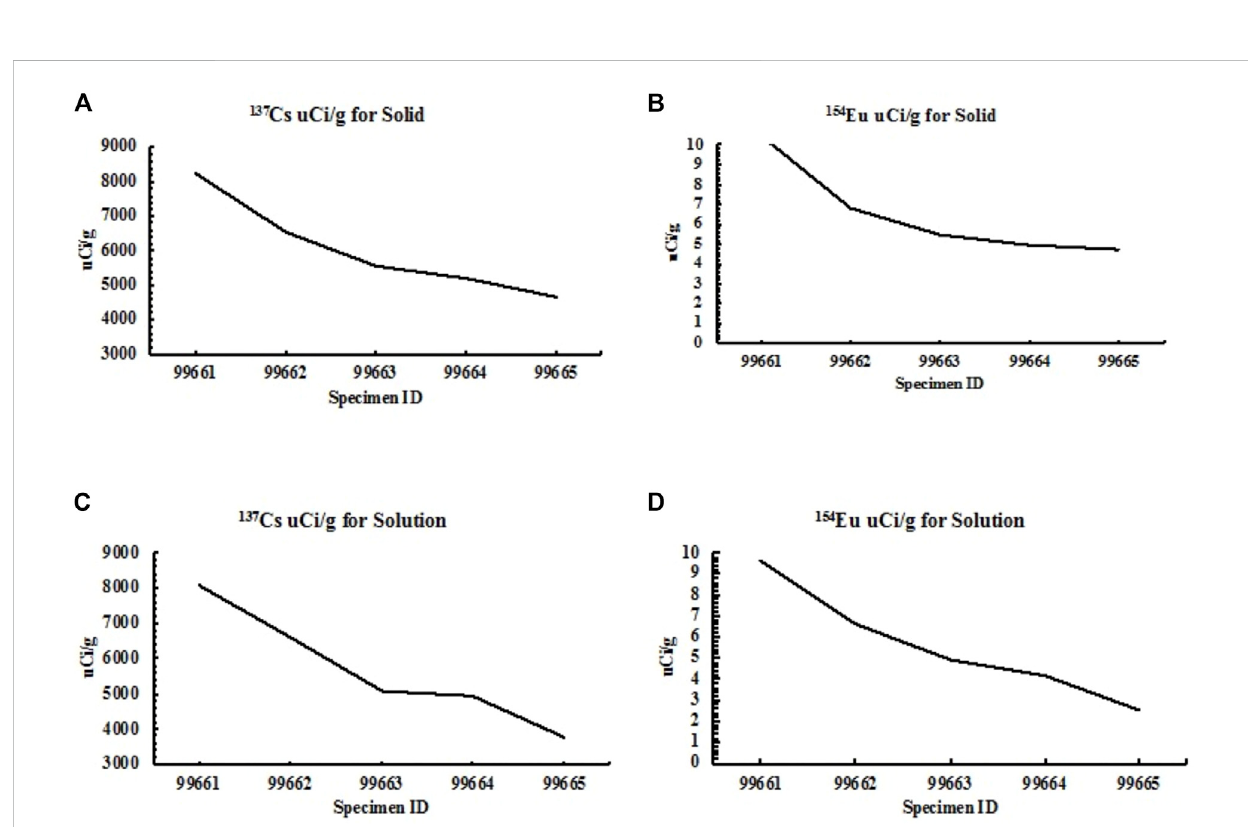
Results for 134 Cs (A) and 154 Eu (B) gamma spectroscopy as measured as a solid, and 134 Cs (C) and 154 Eu (D) as measured in